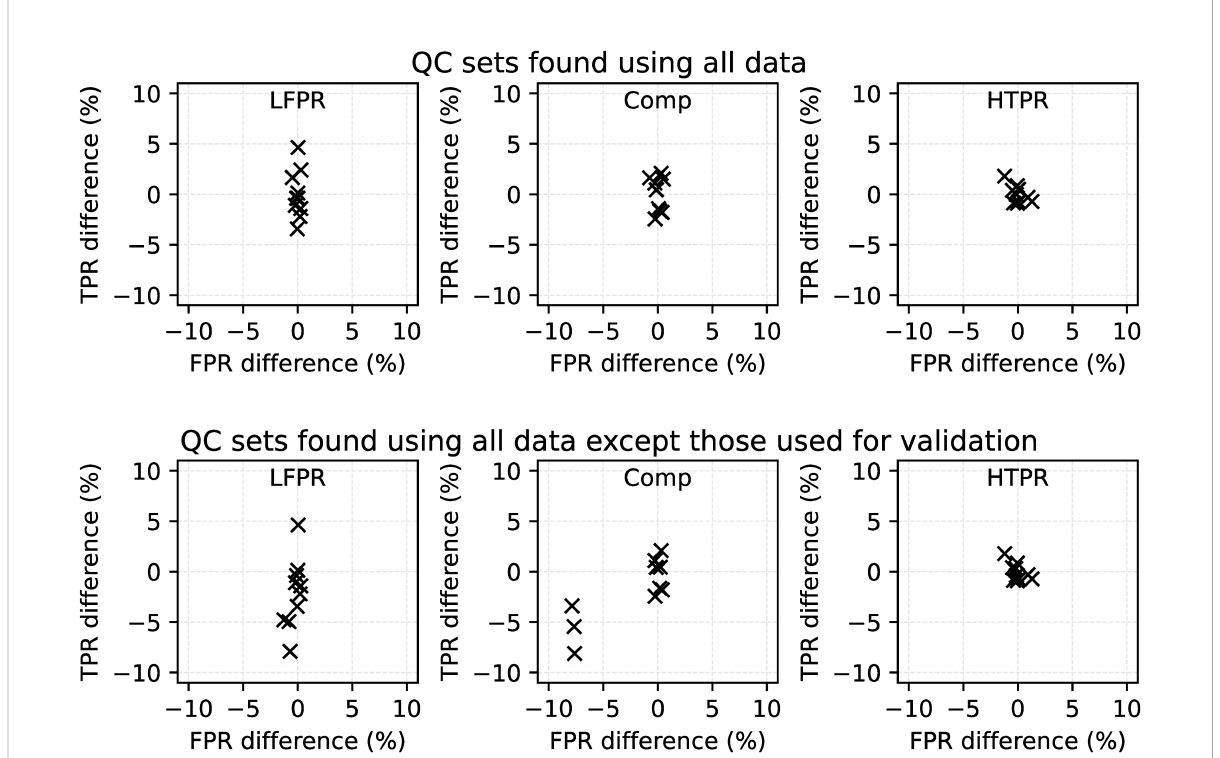
FIGURE 6 Top row: TPR and FPR calculated when applying the QC sets derived from the full QuOTA dataset to data from each subset minus the TPR and FPR calculated from all the data; bottom row: as top row except the QC sets were derived from all data except those the TPR and FPR were calculated